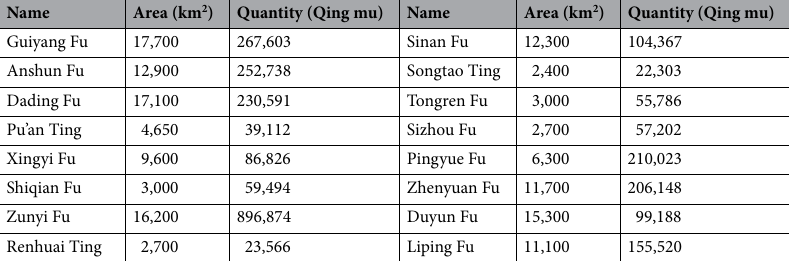
Table 2. Cropland data in the register.